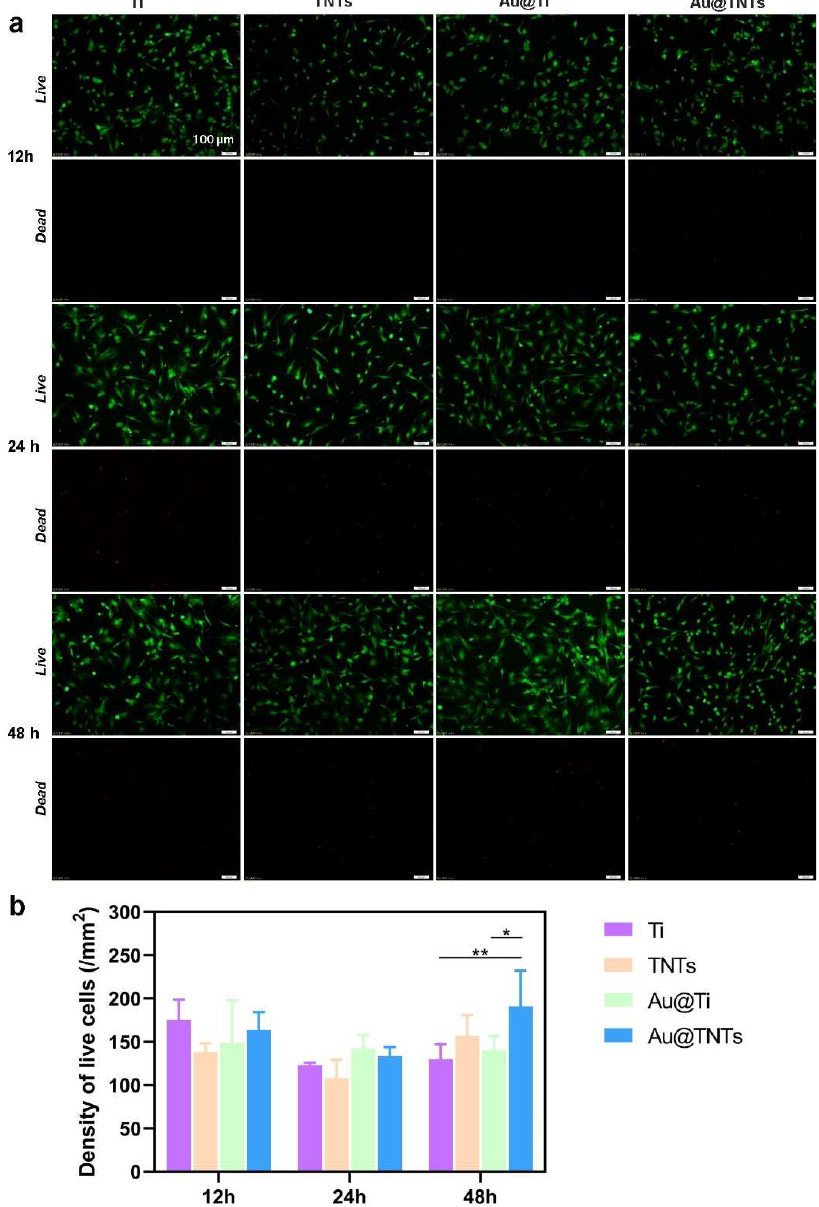
Figure 4. ( a ) Fluoroscopy images of live/dead staining of rBMSCs cells on various samples. ( b ) Den- sity of live cells after 12, 24, and 48 h of culture on different samples ( n = 6, * p < 0.05, ** p < 0.01).